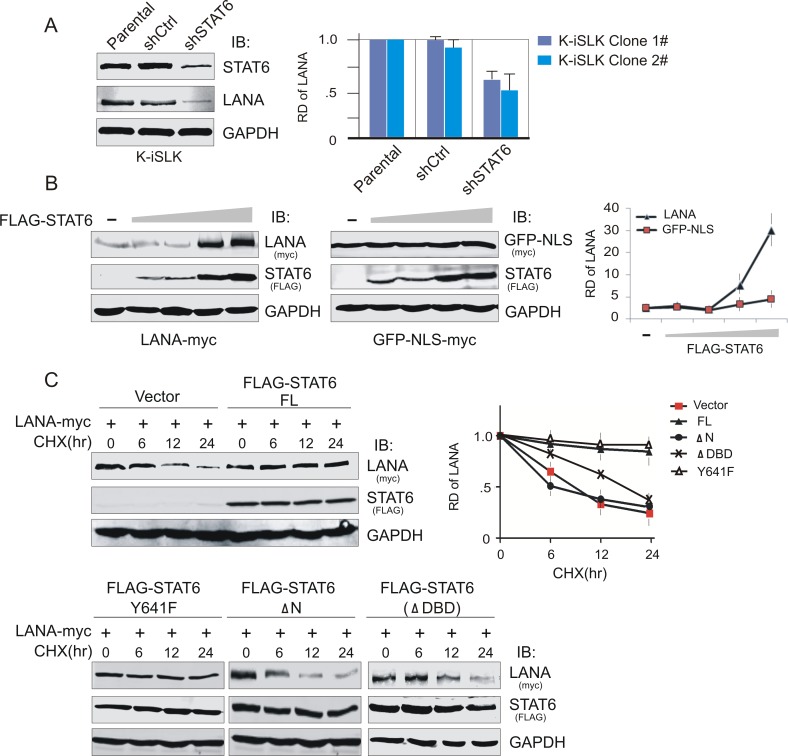
STAT6 contributes to the protein stability of LANA.(A) Knockdown of STAT6 reduces the expression level of endogenous LANA in KSHV-infected cells. Parental and K-iSLK cells with lentivirus-mediated knocked down of STAT6 (shSTAT6) or luciferase control (shCtrl), were subjected to immunoblotting. The relative density (RD) of protein level of LANA protein was individually quantitated based on triplicate experiments from two independent clones and shown on the right panel. (B) STAT6 stabilizes LANA in a dose-dependent manner. HEK293T cells were co-transfected LANA-myc (2μg) with different dosages of FLAG-STAT6 (0, 1, 2, 5, 10μg). 48hr post-transfection, cells were harvested and lysed for immunoblotting as indicated. The CMV-driven promoter plasmid GFP-NLS-myc was used as a control. The relative density (RD) of protein level of LANA or GFP-NLS is quantified based on triplicate experiments and shown on the right panel. (C) STAT6 enhances the protein stability of LANA. HEK293T cells were co-transfected by LANA-myc with full length (FL) FLAG-STAT6, its mutants (Y641F, deletion with amino-domain ΔN or DNA-binding domain ΔDBD) or vector alone. 36hr post-transfection, cells were treated with Cycloheximide (CHX) 20μg/ml for the indicated time before harvesting and lysing for immunoblotting. The relative density (RD) of protein level of LANA is quantified based on triplicate experiments and shown at the right panel.